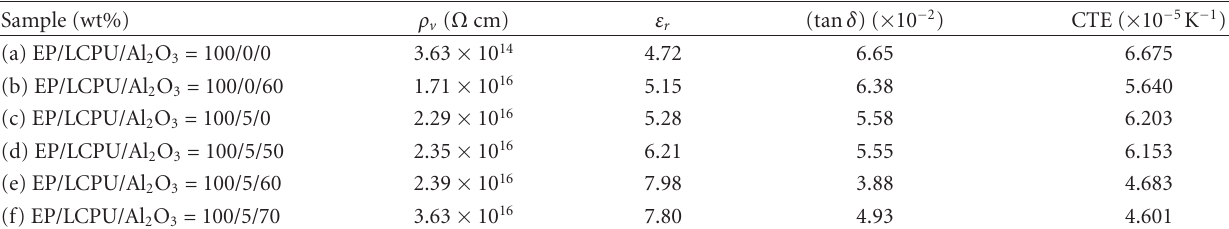
Table 3: Electrical performance of the